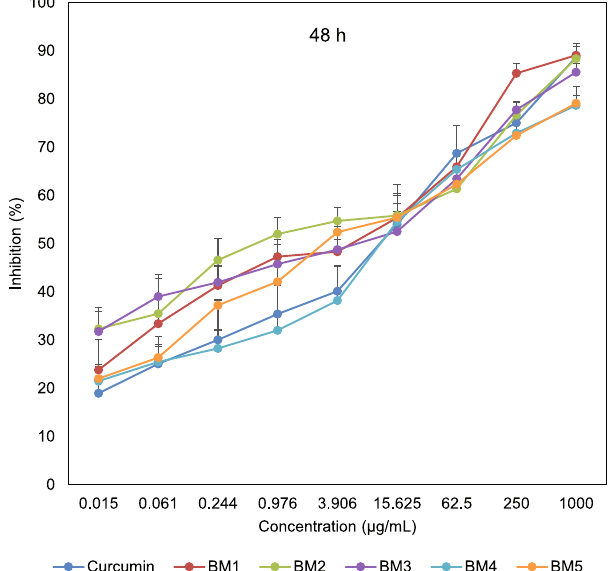
Figure 4. Inhibitory effect of synthesized compounds on AGS cells assessed with MTT assay after 48 h time point.